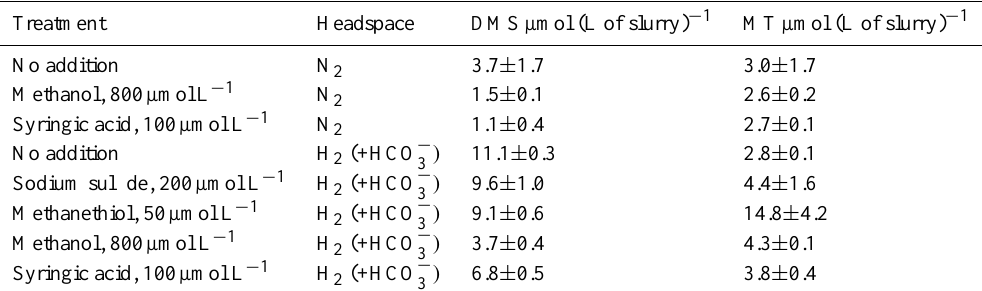
Table 1. Concentrations of DMS and MT after 12 days of incubation with inorganic and organic substrates. Results are presented as means and standard errors from duplicate tubes.